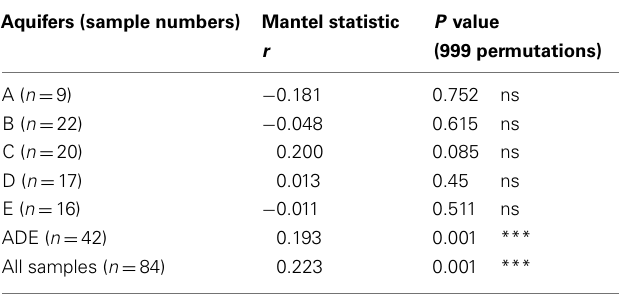
Table 3 | Mantel test between species data sets (Bray–Curtis) and spatial data sets (Euclidean